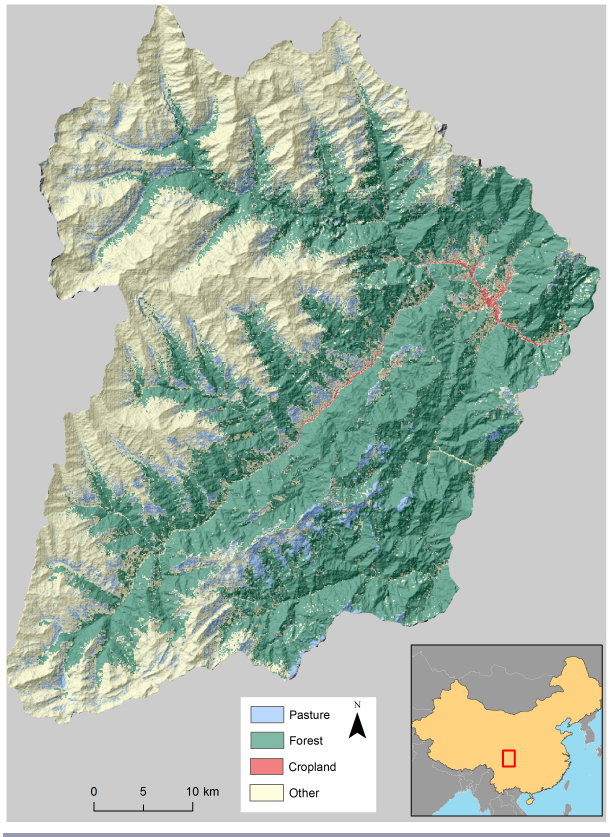
Fig. 2 . The Wolong Nature Reserve, China, and its satellite- derived 2007 land cover